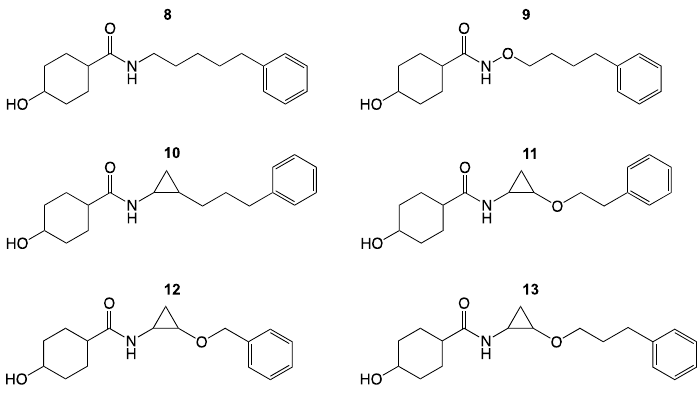
Figure 7. Linker variants of 8 . Table 4. Functional and pharmacokinetic properties of 8 linker variants. 2 and 8 values are duplicated from Tables 2 and 3, respectively, for comparison.